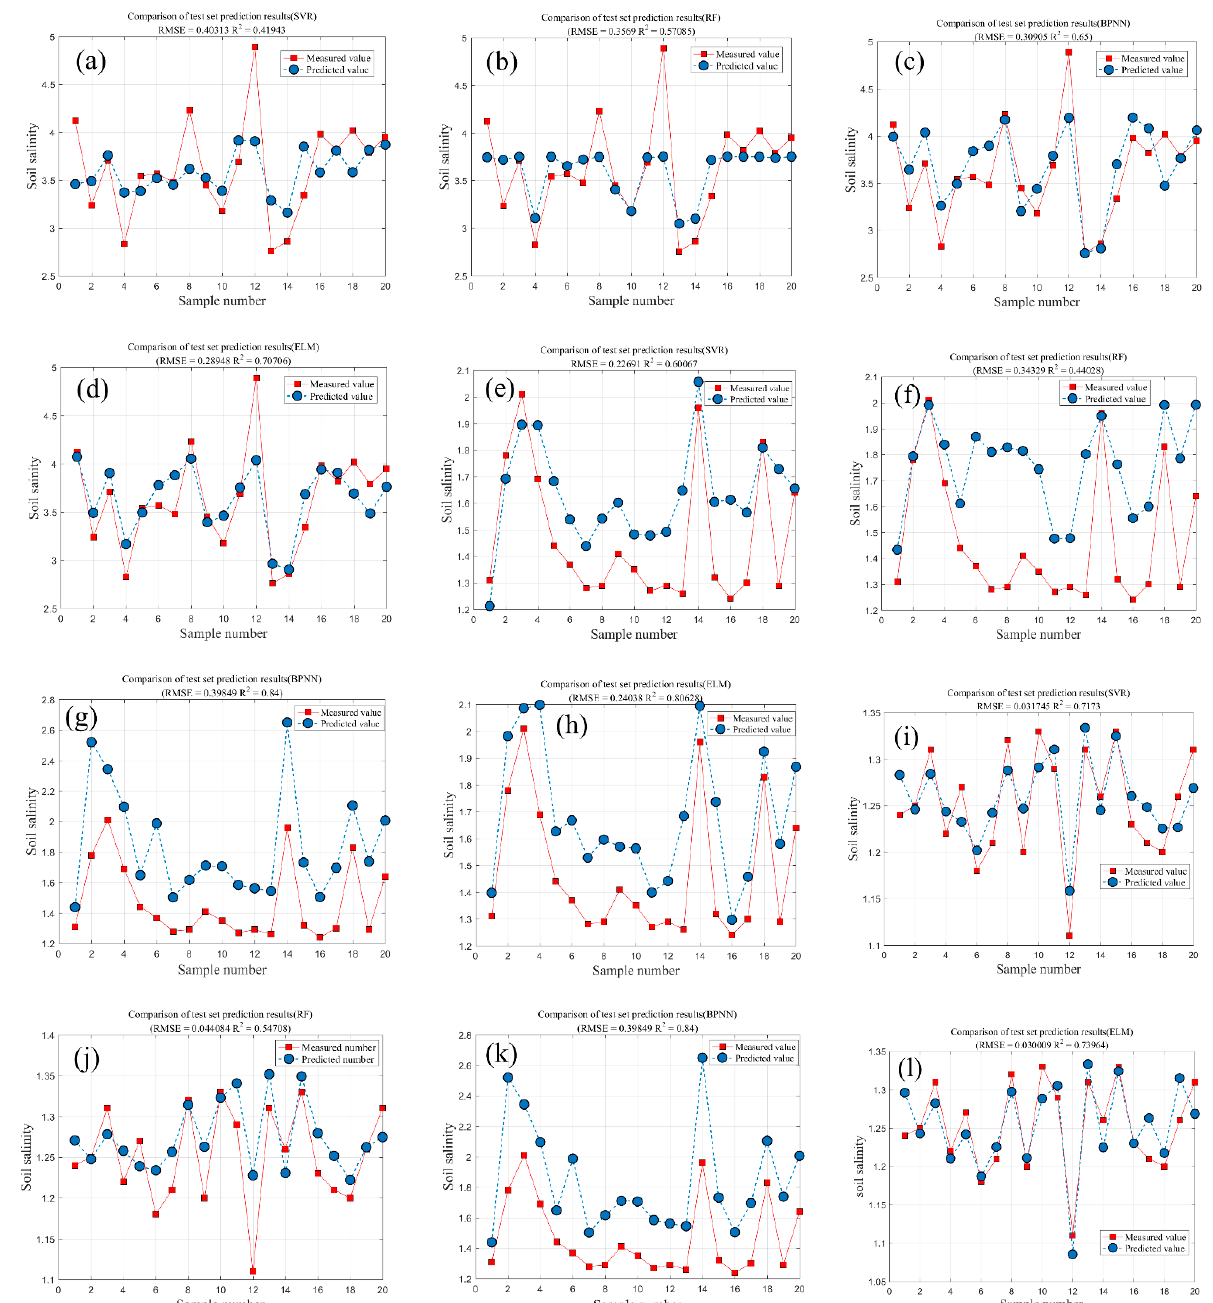
Figure 3. The proposed model prediction results. Note: ( a ) Bare land SVR model; ( b ) Bare land RF model; ( c ) Bare land BPNN model; ( d ) Bare land ELM model; ( e ) Alfalfa-covered land SVR model; ( f ) Alfalfa-covered land RF model; ( g ) Alfalfa-covered land BPNN model; ( h ) Alfalfa-covered land ELM model; ( i ) Wheat-covered land SVR model; ( j ) Wheat-covered land RF model; ( k ) Wheat-covered land BPNN model; ( l ) Wheat-covered land ELM model.